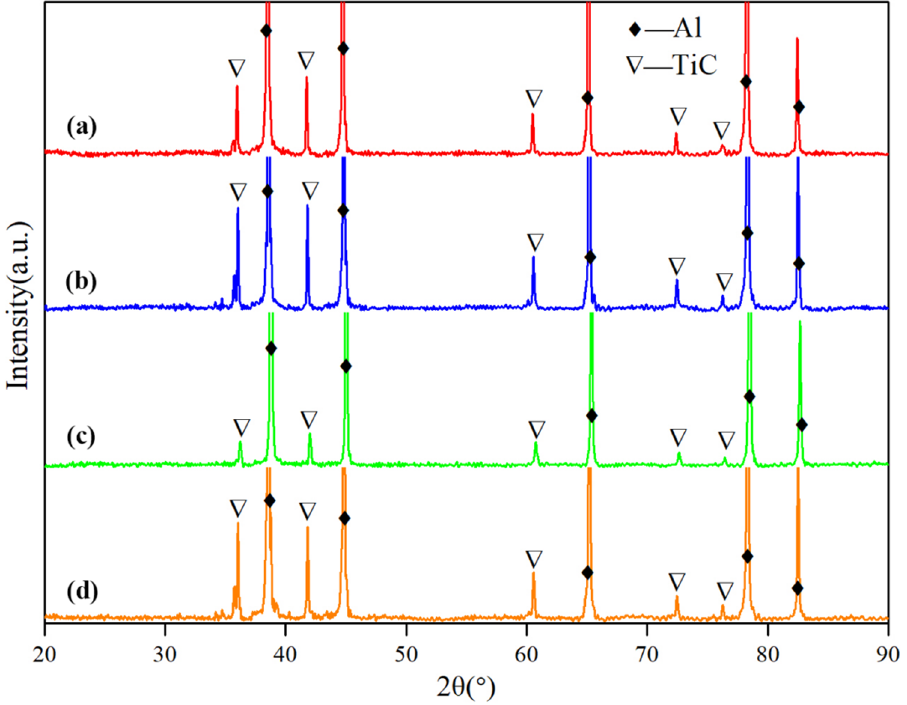
Figure 3. XRD results of as-cast Al-4Ti-1C prepared by different carbon sources: ( a ) 30 μ m graphite, ( b ) 4 μ m graphite, ( c ) 10 μ m diamond, and ( d ) 6 μ m diamond.